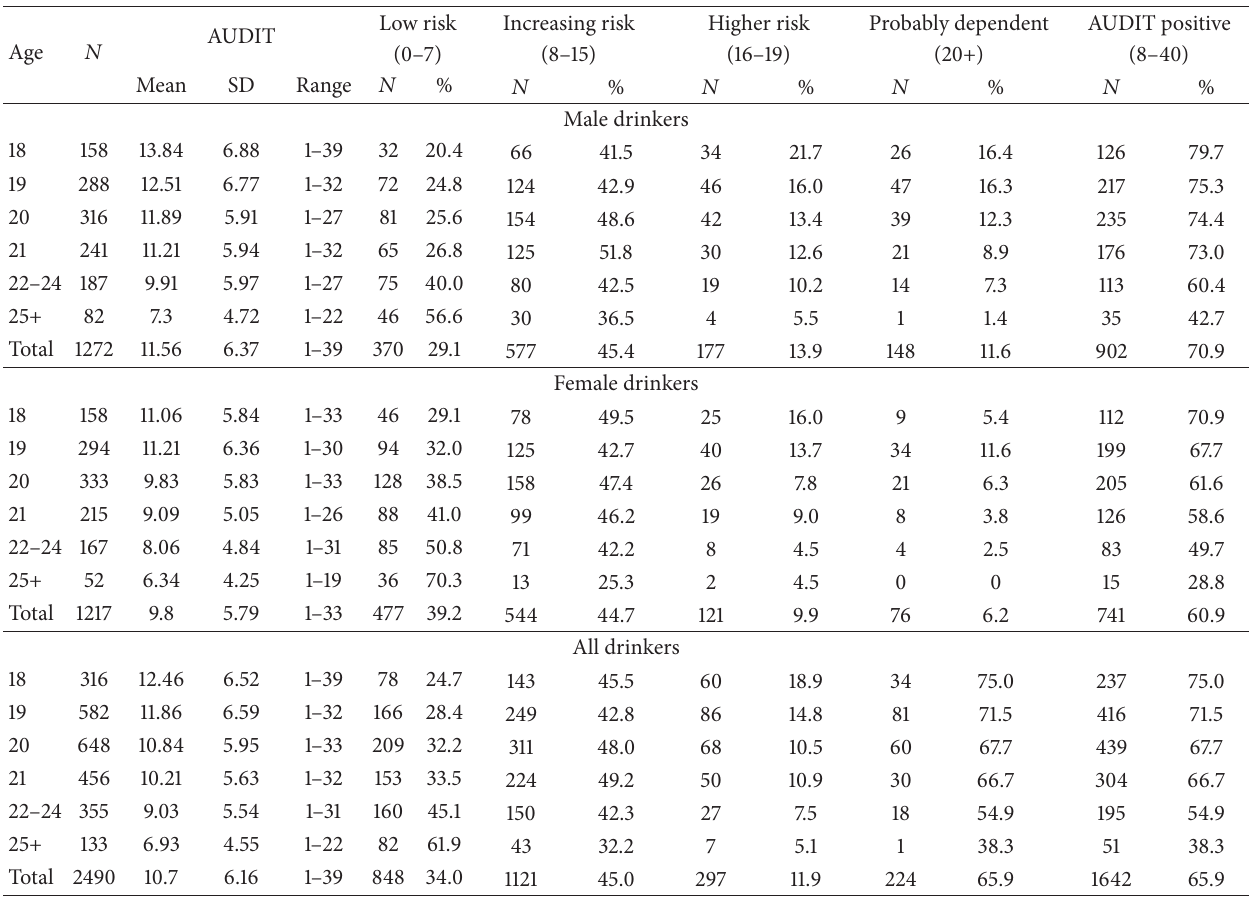
Table 2: Mean (SD) and range of AUDIT scores weighted by age, gender, and ethnicity.